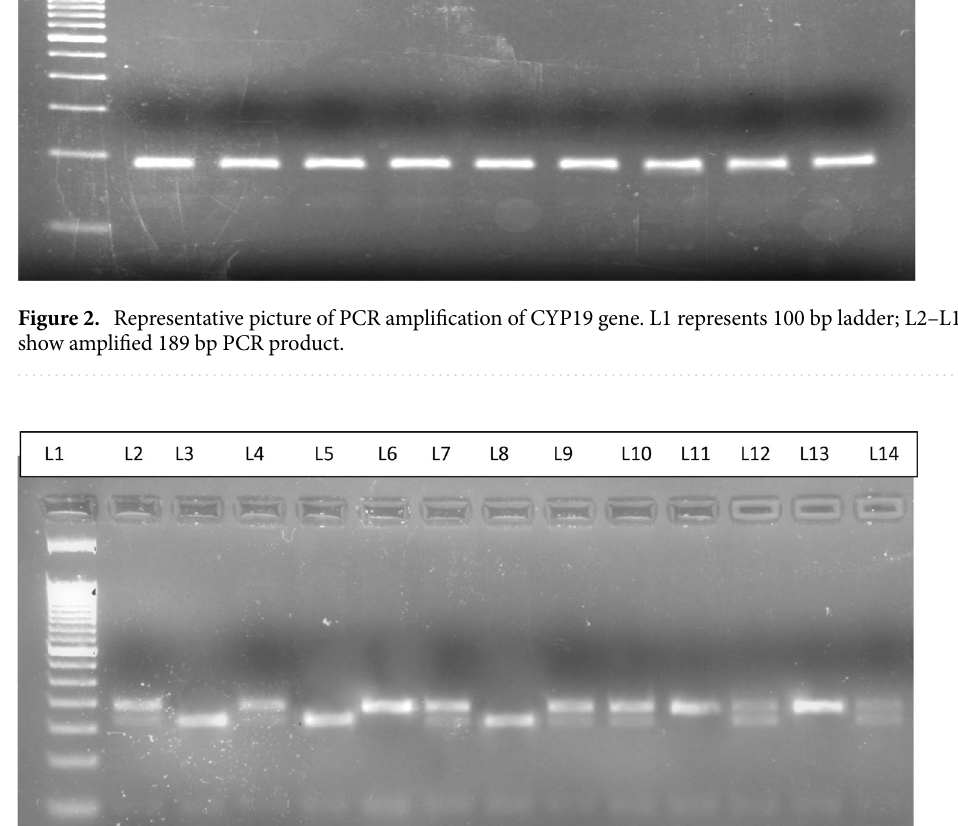
(p < 0.001). The mean levels of fasting insulin, HOMA-IR, FGIR and QUICKI also varied significantly between PCOS women as compared to healthy women (p < 0.001). Distribution of SNP (rs2414096) of CYP19 genotypes and alleles. For genetic analysis DNA was extracted from peripheral blood leukocytes (Fig. 1). All the subjects were then screened for G/A polymorphism in the CYP19 gene. The region containing G/A SNP (rs2414096) was amplified that resulted in a 189 bp fragment (Fig. 2).